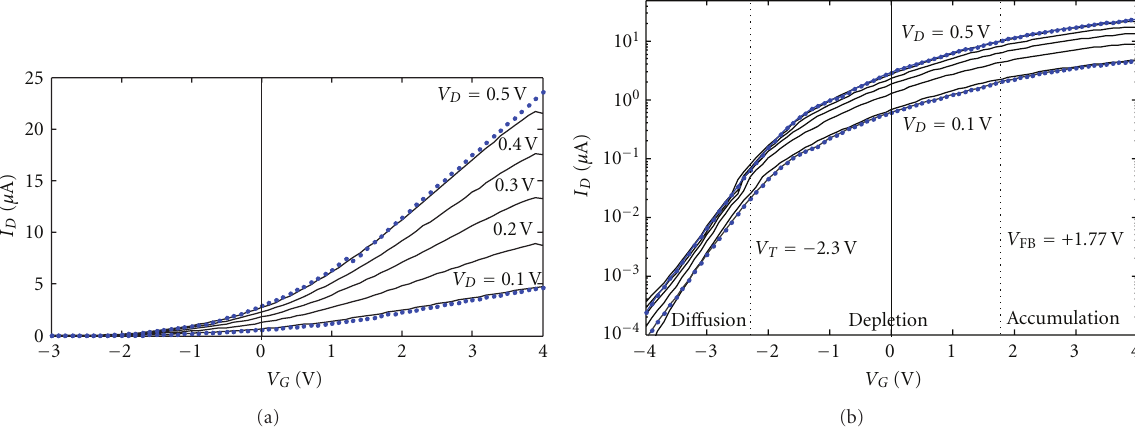
Figure 2: Experimental I DS - V GS characteristics: linear scale in (a) and semi-log in (b). The measurements are taken in dark conditions (solid lines) for several values of V DS between 0.1V and 0.5 V. The dotted lines result from the calculated current according to the proposed unified model. For clarity, only results obtained for V DS = 0 . 1V and V DS = 0 . 5 V are presented. The V GS domains of the operation modes are specified in